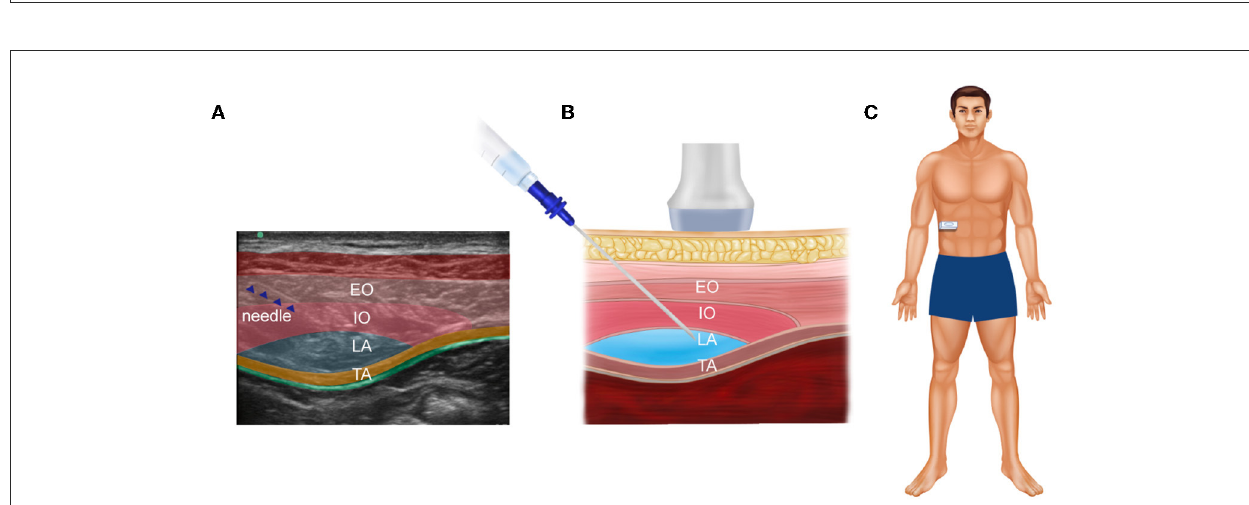
FIGURE3 An ultrasound of abdominal muscles and fascia in the lateral TAP. (A) Real ultrasound image of the patient; (B) the corresponding schematic view, which is used to show the injection site more clearly; (C) the specific position of the ultrasonic probe on the patient’s abdomen. EO, external oblique muscle; IO, internal oblique muscle; TA, transversus abdominis; LA, local